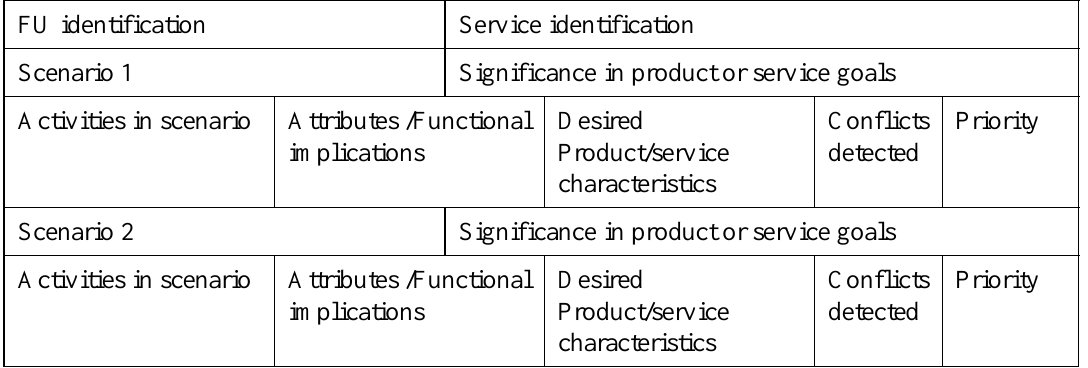
Table 2. Requirements for activity analysis, simplification of User Fit